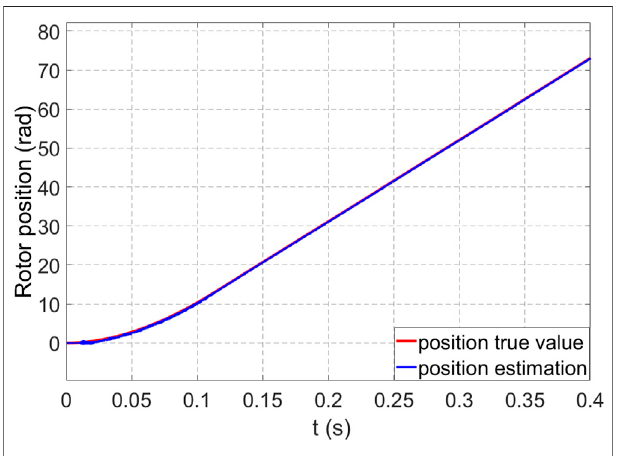
FIGURE 6 | Identi fi cation value of α -axis current.